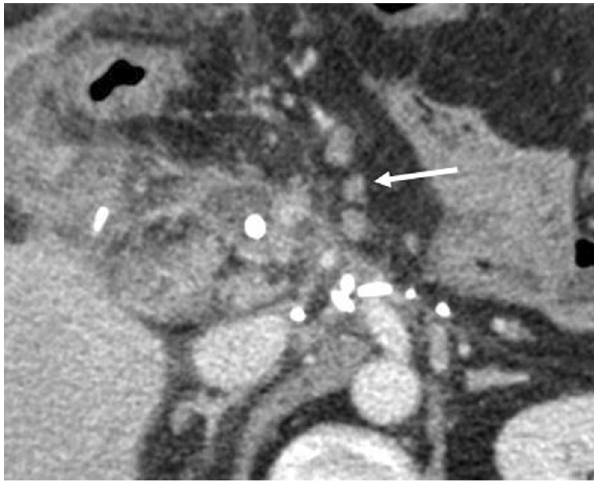
Fig. 11 Inflammatory adenopathy. Axial CT image shows the presence of enlarged lymph nodes (white arrow) in the mesentery, close to the surgical bed